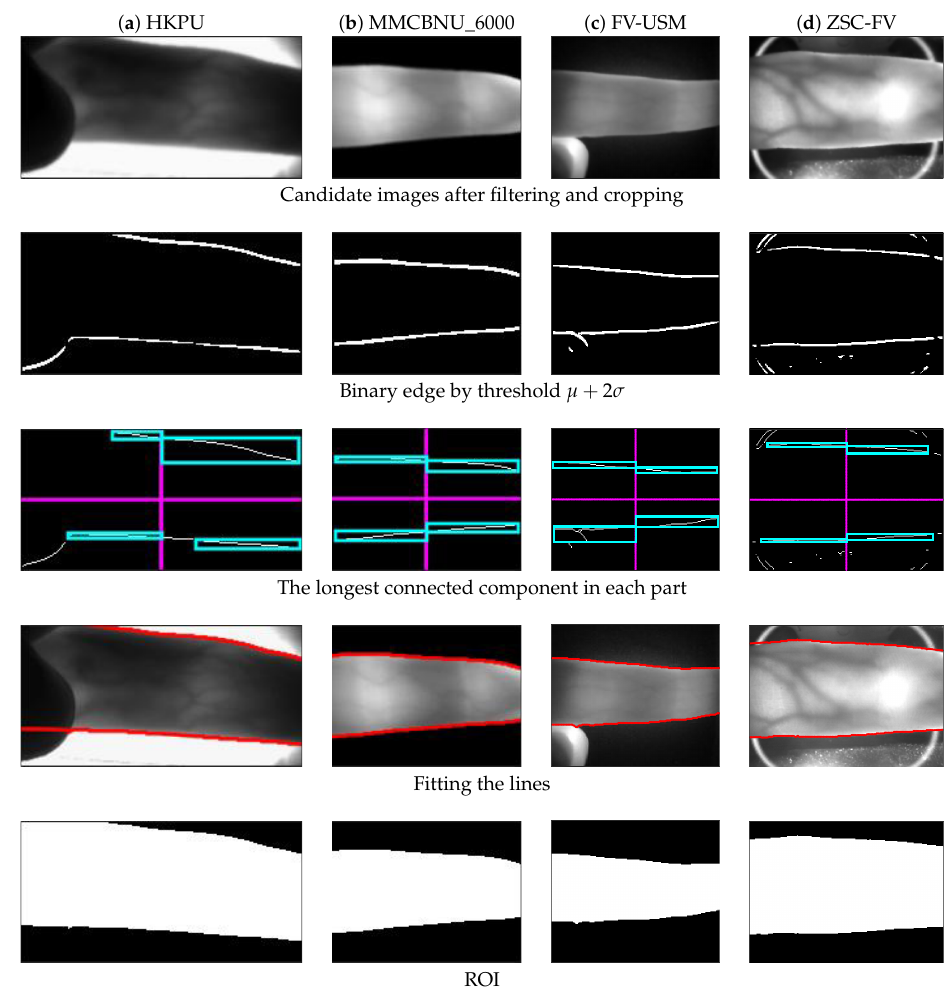
Figure 6. Processing results of some good-quality images from the four datasets,